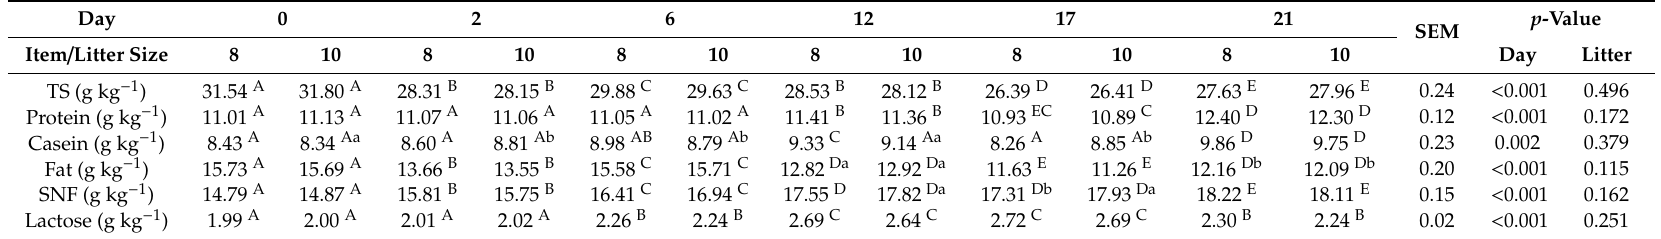
Table 2. The e ff ect of litter size and lactation day on the gross composition of rabbit